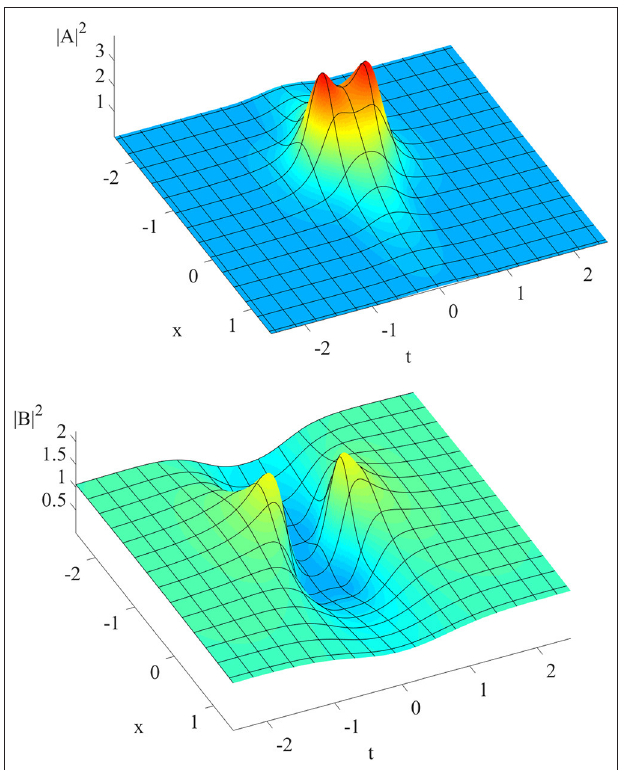
FIGURE 4 | Wave intensities | A | 2 (top) and | B | 2 (bottom) vs. space x and time t , clearly illustrating the “double peak” structure.